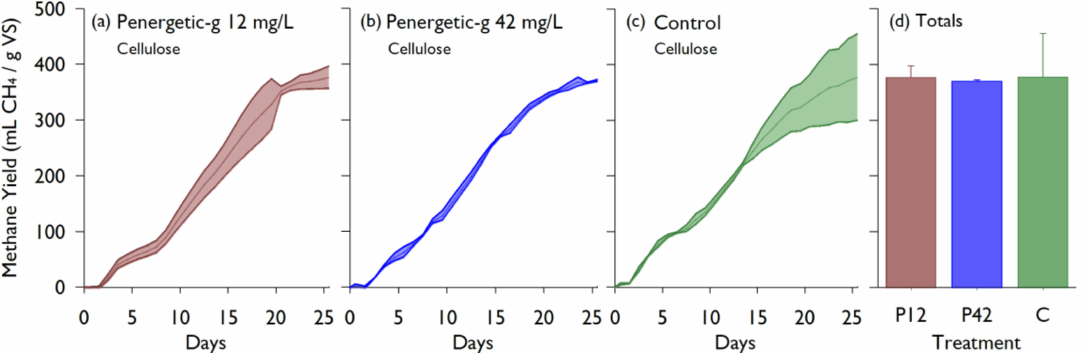
Figure 4. Cumulative methane yields over time from cellulose BMP batch cultures containing the Penergetic-g ® additive at 12 mg / L ( a ), 42 mg / L ( b ), or without additive ( c ). Each timeseries shows the mean ± standard deviation (n = 3). The total yield for all treatments are compared in the bar graph, with the error bars showing standard deviation ( d ). Yields are scaled by volatile solids (VS).